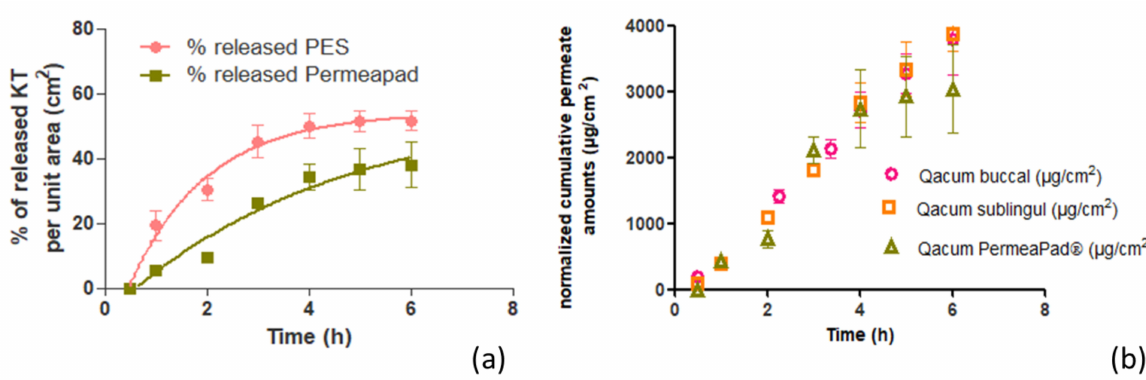
Figure 3. In vitro and ex vivo assays. ( a ) Representation of the percentage of released KT per unit area (cm 2 ) from the PES membrane (pink curve) and the PermeaPad ® biomimetic membrane (green curve). ( b ) Cumulative amount of KT permeated ( µ g/cm 2 ) under an infinite dose regimen through buccal and sublingual mucosae and biomimetic membrane upon application of KT hydrogel. Values represent means ± SD (n =